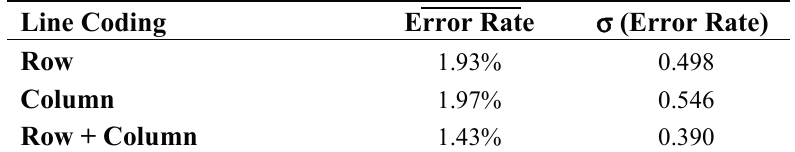
Table 9. Classification error rates for line coding based on line